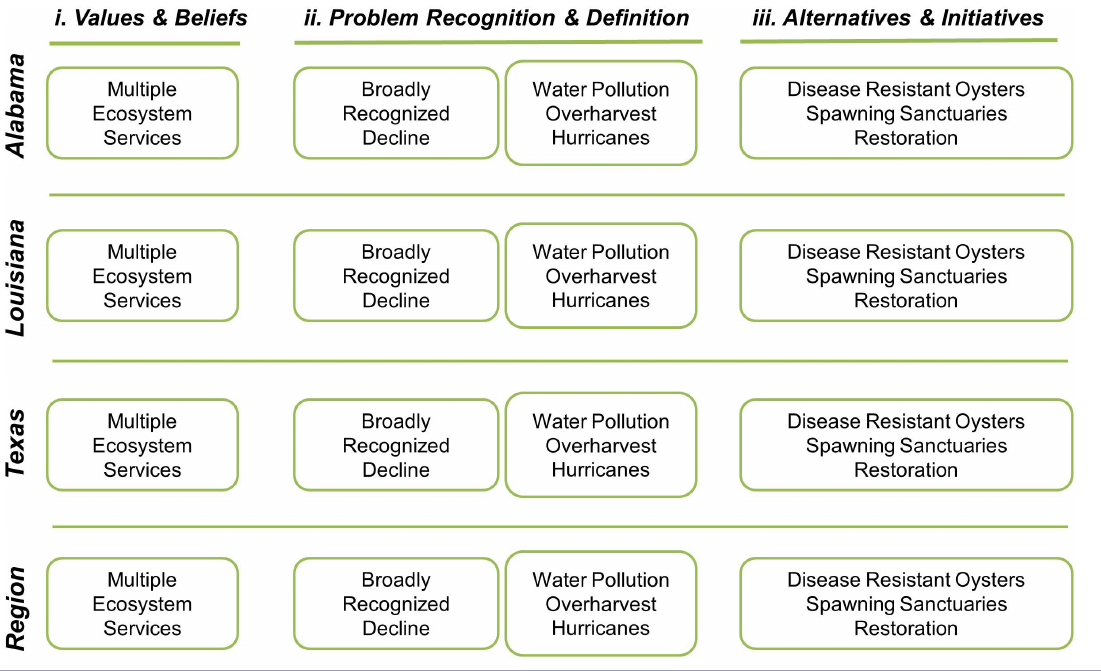
Fig. 8 . Figure highlighting the wide recognition of numerous ecosystem services, broadly declined oyster reefs caused my multiple stressors, and identifying well-supported stewardship initiatives at state and regional